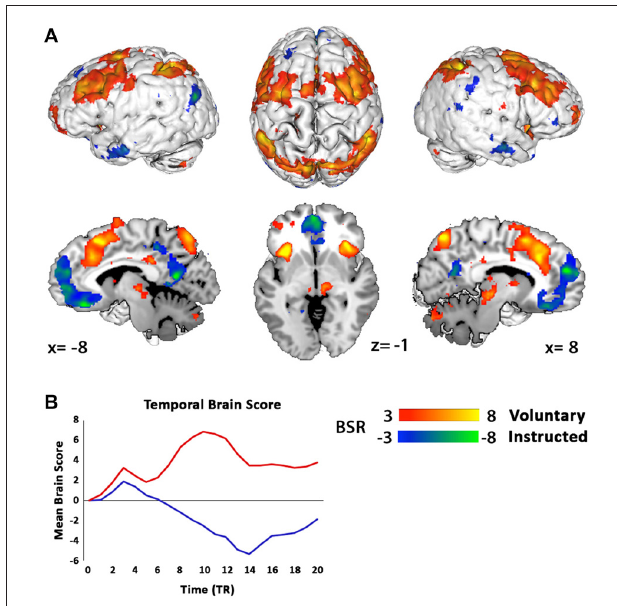
FIGURE 3 | Partial least squares (PLS) analysis separates networks of regions where activations covaried with the onset of Voluntary decisions (red) and Instructed decisions (blue) at the start of the trial. (A) For Voluntary decisions, regions of the frontoparietal and salience networks were active, including the anterior cingulate cortex (ACC), supplementary motor area, bilateral dorsolateral prefrontal cortex (DLPFC), inferior parietal lobes (IPL) and insular cortices. Instructed decisions engaged a separate network, with activation predominantly in the medial prefrontal cortex. Results are thresholded at a bootstrap ratio (BSR) of 3 and displayed using Mango (Research Imaging Institute, UTHSCSA). (B) Mean brain scores of the LV1 pattern ( p < 0.001) across the entire brain of each participant for Voluntary (red) and Instructed (blue) decisions over 21 TR scans (TR = 0.7 s; equivalent to 15 s of a hemeodynamic response) shows a functional differentiation between conditions. Note that the “negative” brain score here for Instructed decisions indicates that this network was dissociated from Voluntary decision activity, and does not represent deactivation.